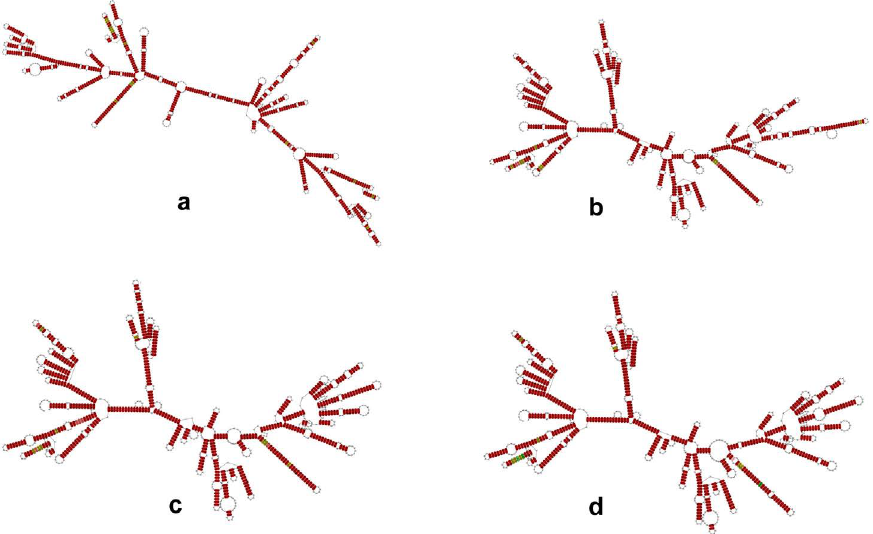
Fig.5. RNAalifold predicted consensus 16S rRNA secondary structures of a Streptomyces LD-21, b Streptomyces LD-29, c Streptomyces LD-34 and d Streptomyces LD-39 with closely-related type strains based on minimum free energy. Regions shaded in brown denote highest degree of conservation with a single number of base pair